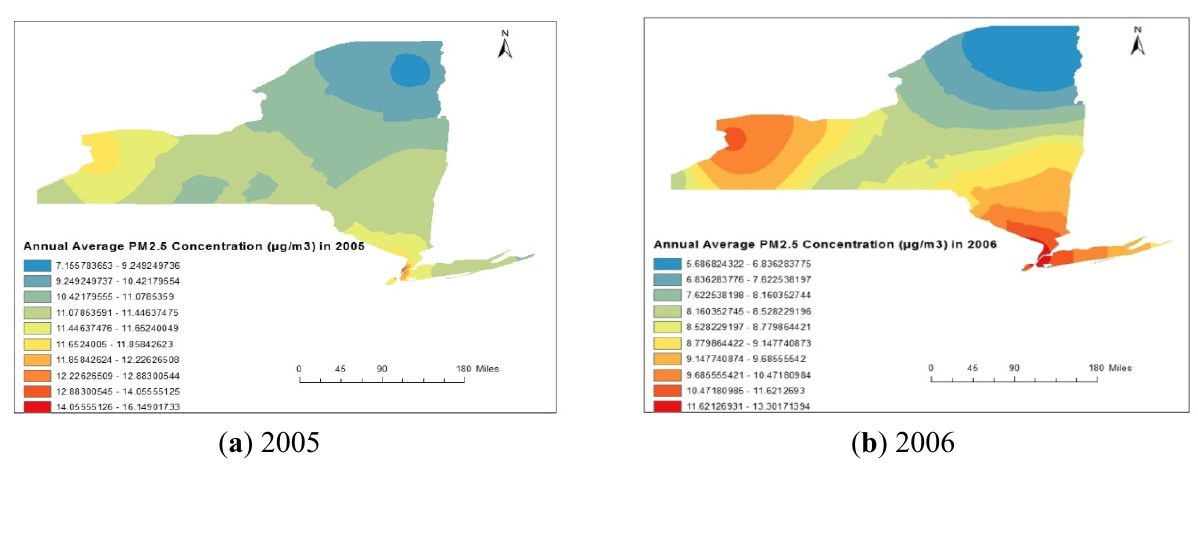
Figure 7. (a – c ) Spatial distribution of annual average 24 h PM 2005 to